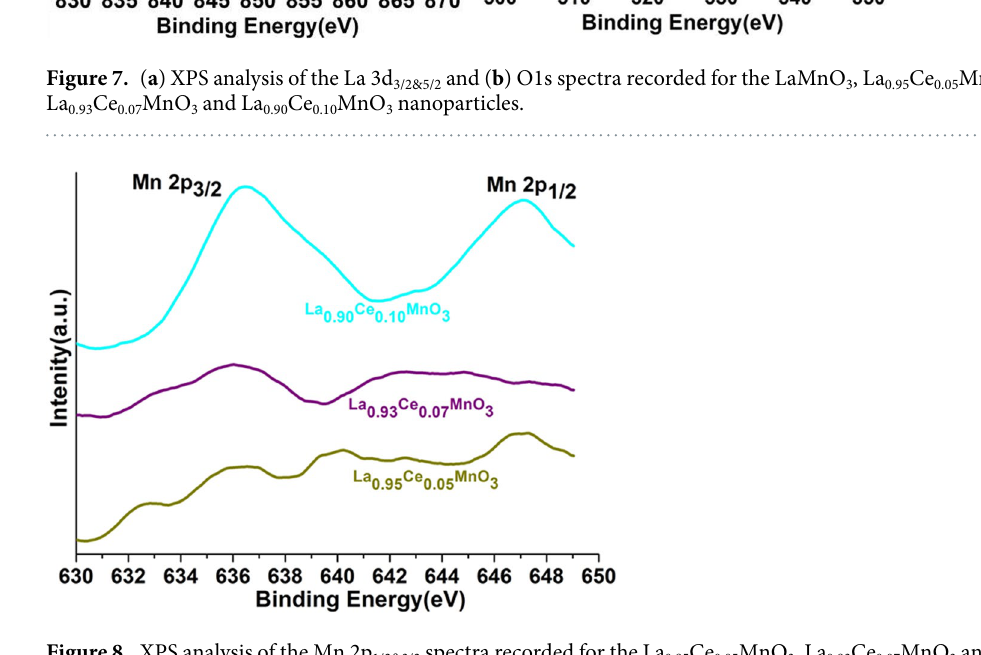
Figure 8. XPS analysis of the Mn 2p 1/2&3/2 spectra recorded for the La 0.95 Ce 0.05 MnO 3 , La 0.93 Ce 0.07 MnO 3 and La 0.90 Ce 0.10 MnO 3